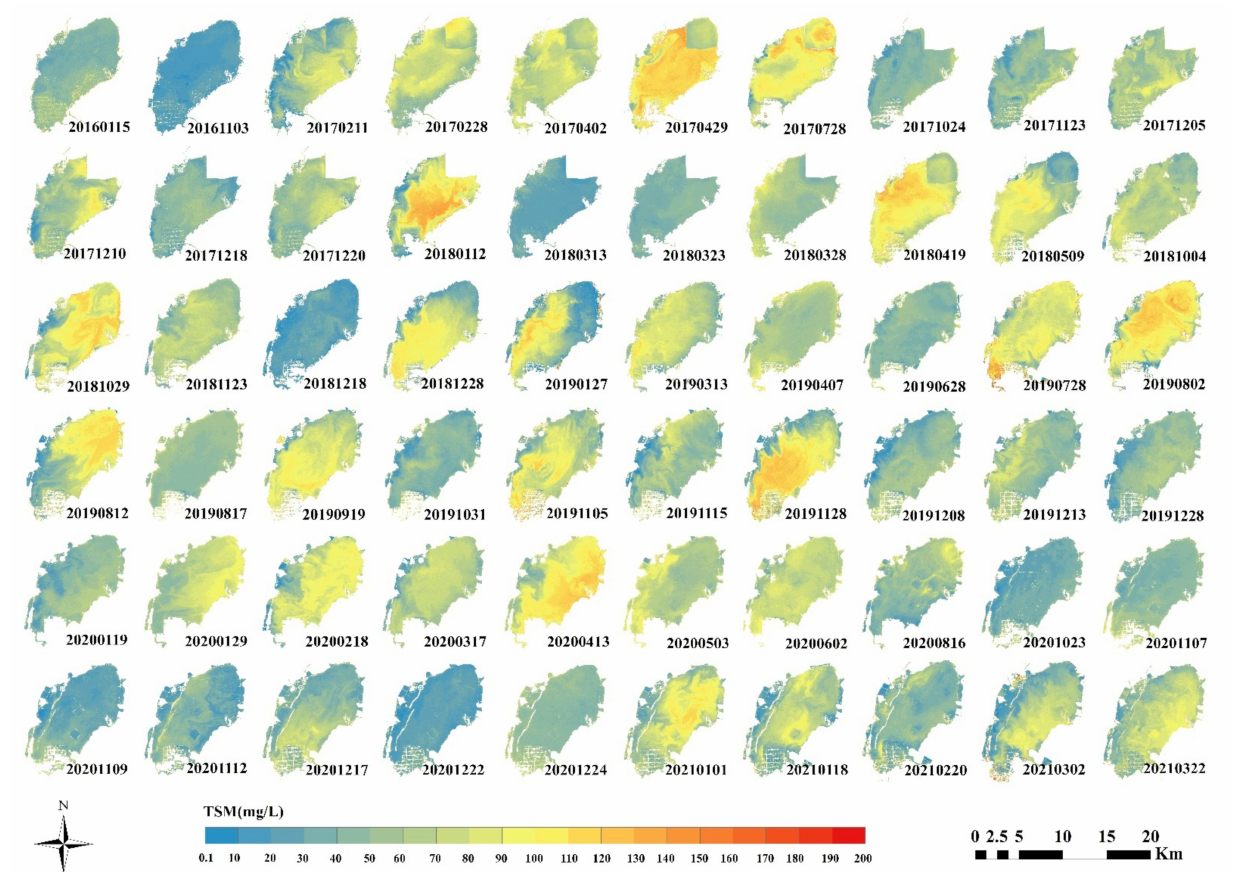
Figure 7. Spatial distribution of TSM concentration in Changdang Lake from 2016 to